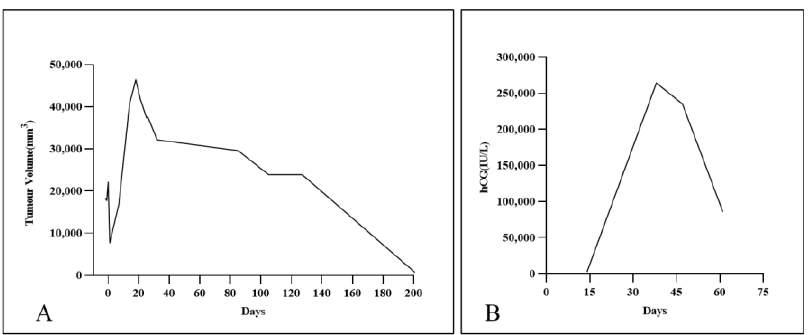
Figure 3. ( A ) The change in the size of the interstitial gestational sac. ( B ) The change in the serum β - hCG level. The day of injection was set as day 0. Mass size = long diameter short diameter 2 /2.